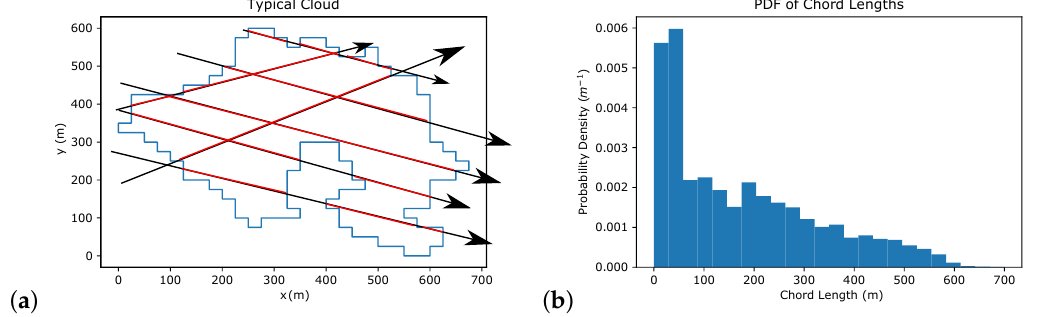
Figure 4. Chord length distribution through a single cloud from the 8th hour of the RICO simulation. ( a ) The projected footprint of the cloud, with transects for illustrative purposes. ( b ) The resulting chord length